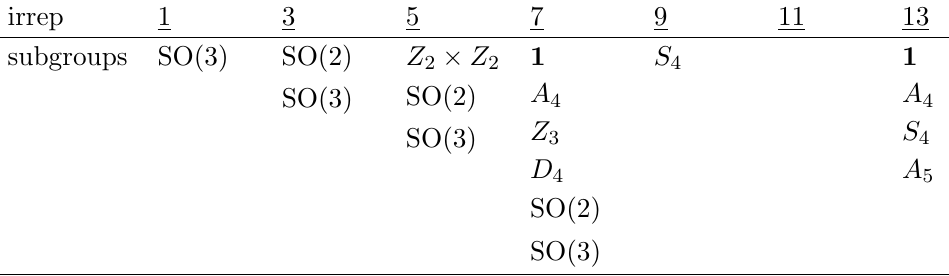
Table 1 . The not systematical stabiliser subgroups in the low-dimensional irreducible representa- tions of the group SO(3)